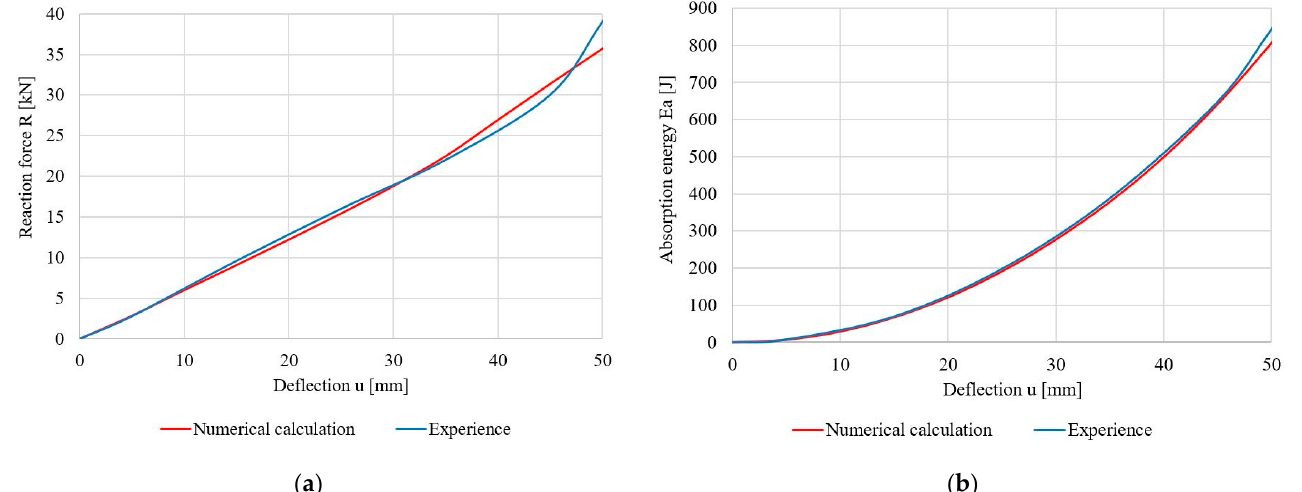
Figure 7. Experimentally determined basic operational parameters of a cylindrical fender 100 mm × 50 mm × 500 mm. ( a ) Reaction force R (kN); ( b ) Absorption energy Ea (J).